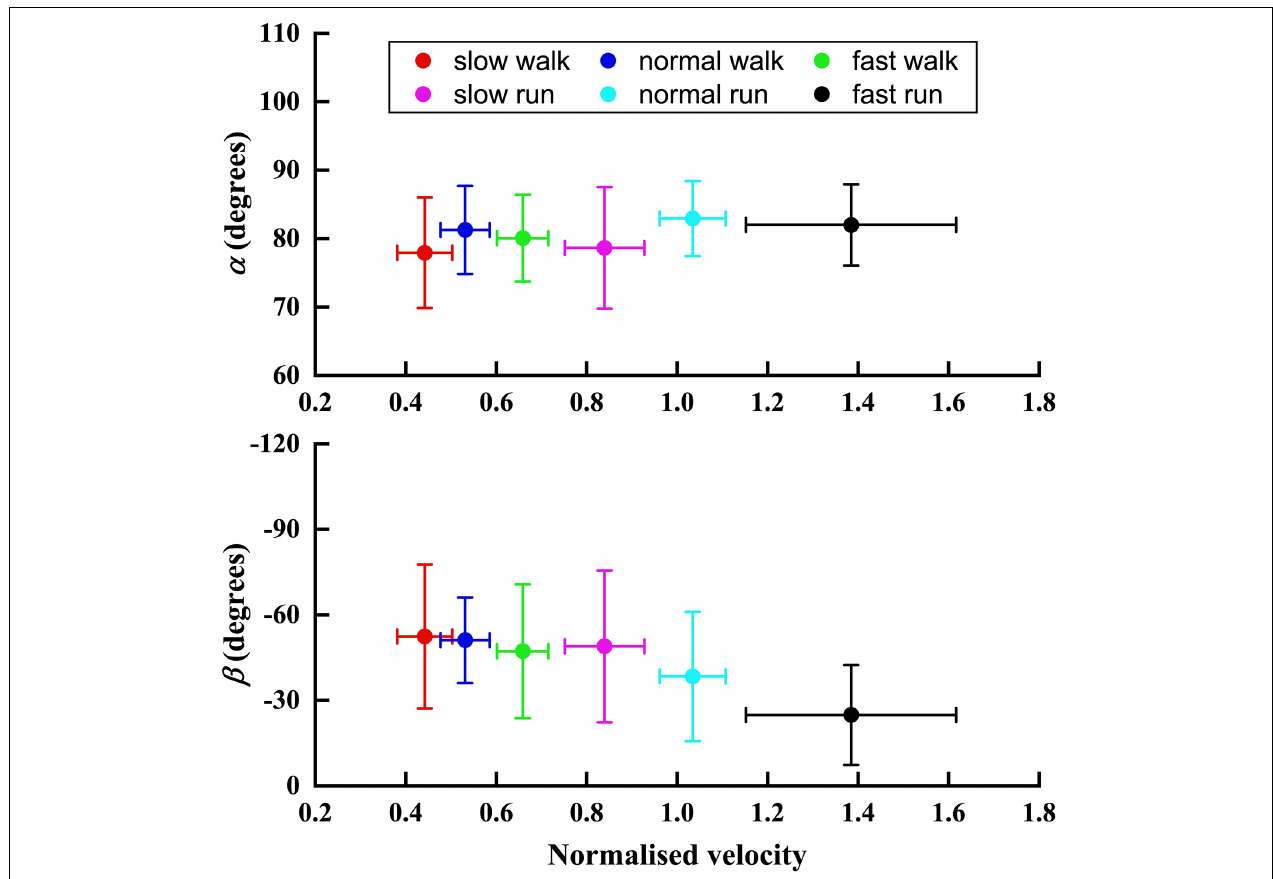
FIGURE 6 | The trend of the orientation angle α and β of FA with the normalised velocity V increasing from slow walk to fast run. Circle plots depict mean; bars depict the 1 SD zones.